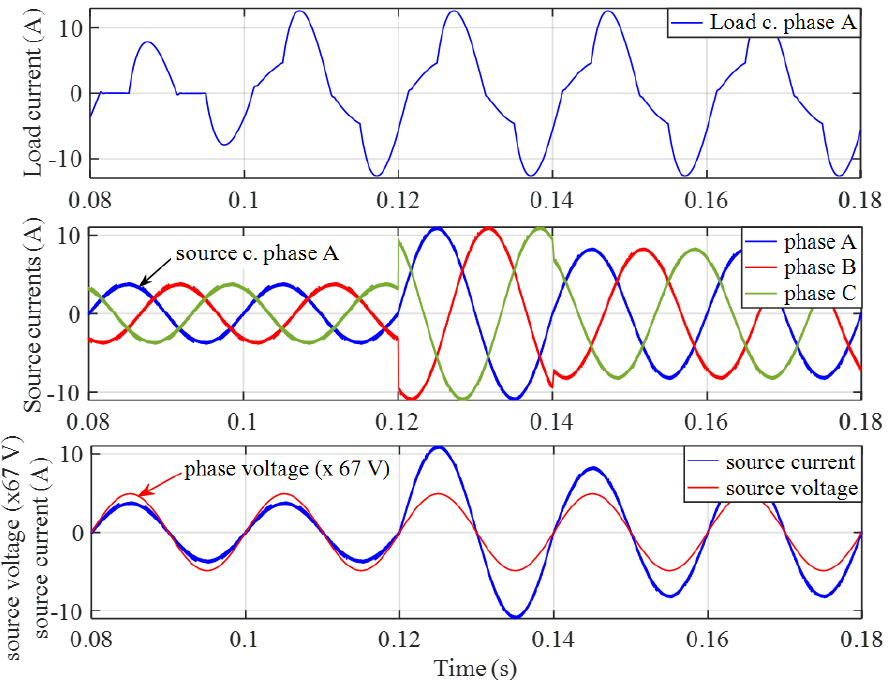
Figure 10. Dynamic response with UpfC control, applying at t = 0.1 s a load change: linear load addition. Up: one phase load current. Middle: source currents, with ITHD = 2.2% after the change. Down: one phase source current and voltage, showing the PF compensation.